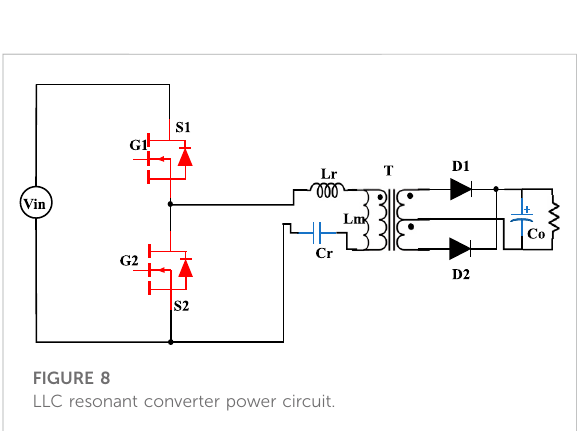
FIGURE 8 LLC resonant converter power